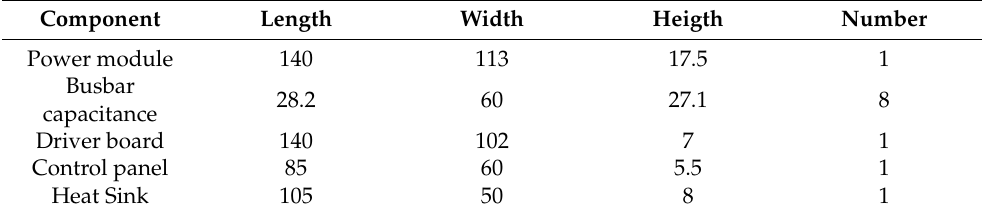
Table 2. Connection point location of bus capacitance and power module.